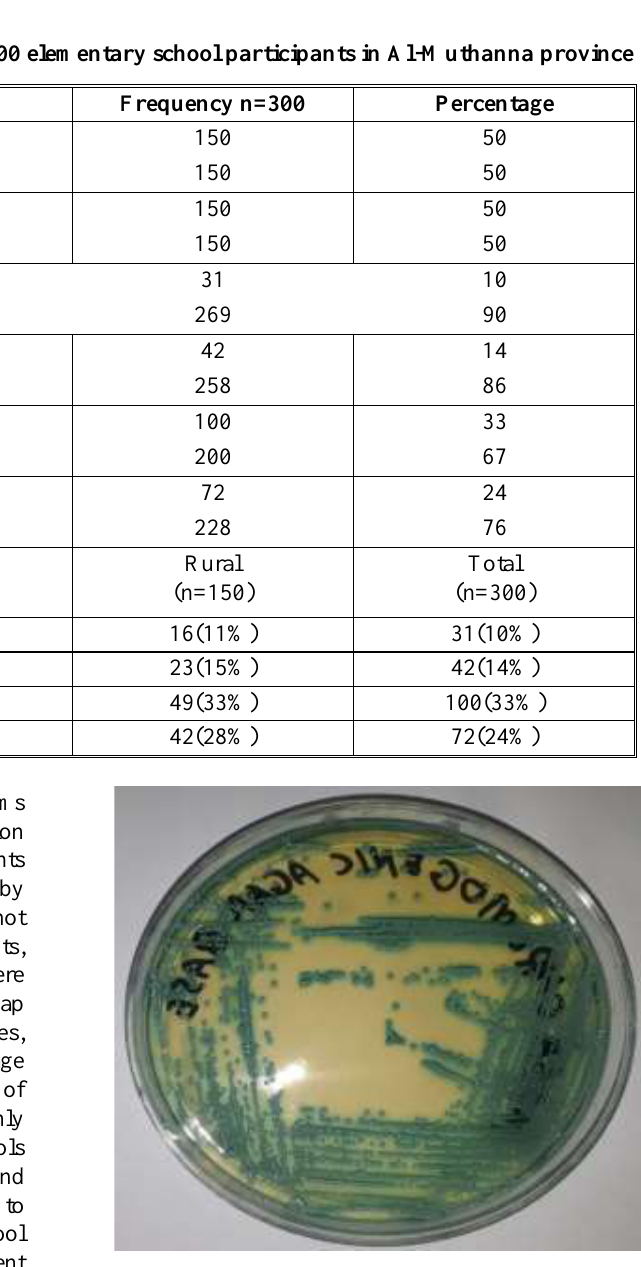
Figure 1. Positive growth of MRSA/VRSA isolates on CHROMagar with greenish colonies due to the cleavage of chromogenic substrate The factors of resident, medication, chronic diseases, and the medical consultation had no correlation with the MRSA nose carriage except the factor of gender, which has been proven to be associated with and contribute to increasing the prevalence of MRSA infections where males have a 2.3 probability higher for MRSA carriers than females (Table